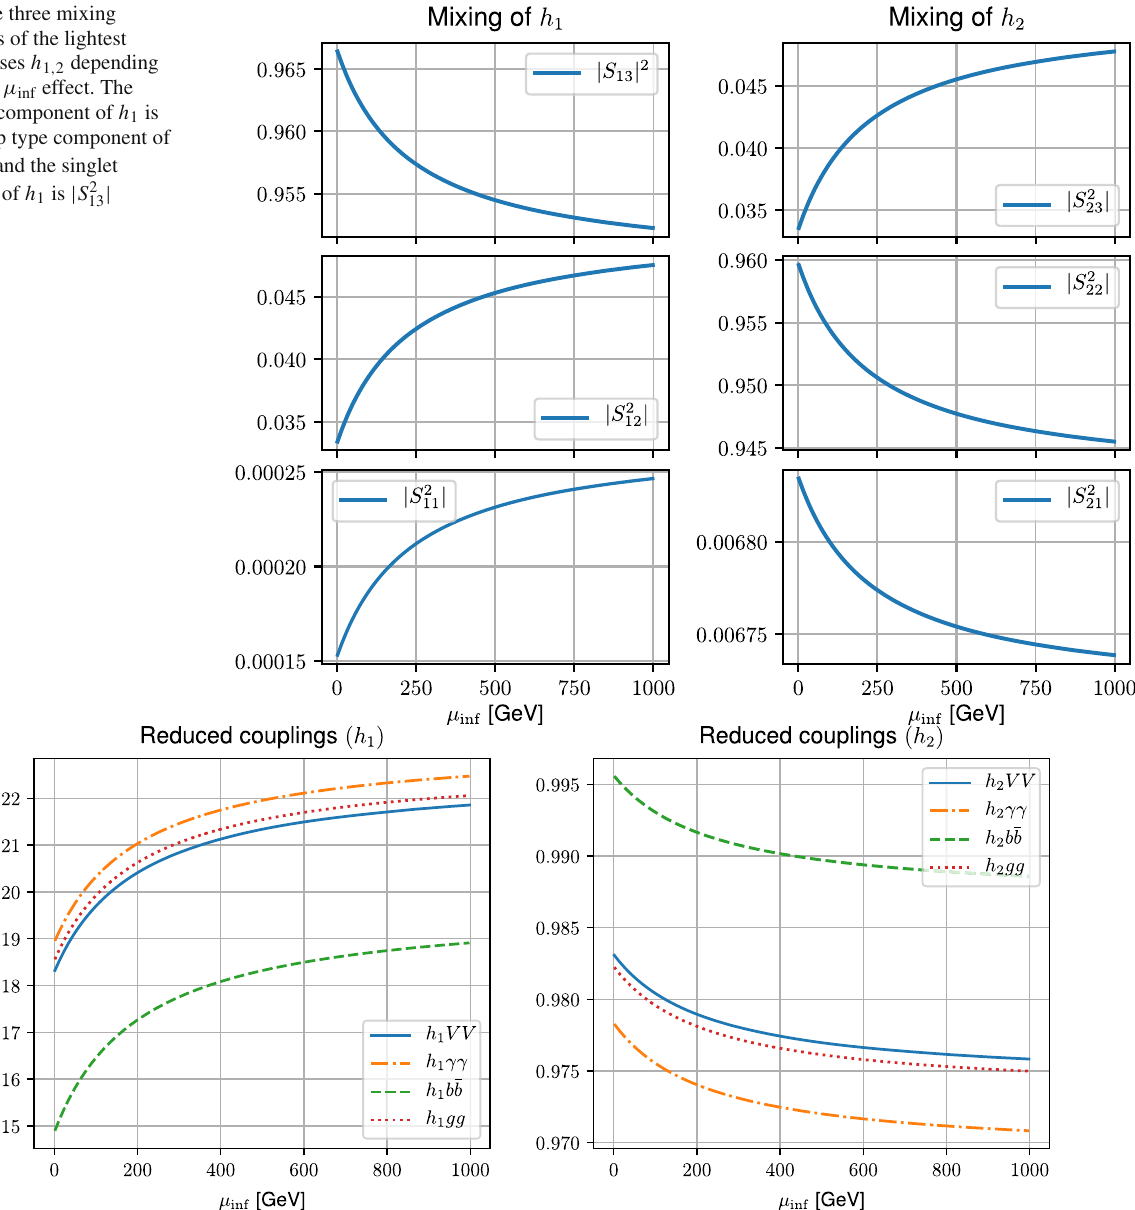
Fig. 8 The reduced couplings of h 1 and h 2 to gauge bosons, photons, b quarks and gluons, depending on the pure μ inf effect